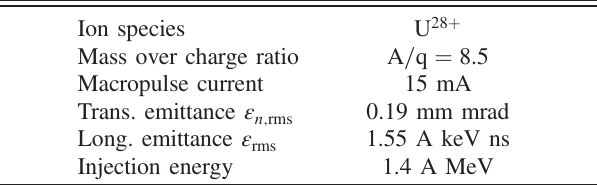
TABLE IV. Beam input parameters of the 85 MV heavy ion linac.